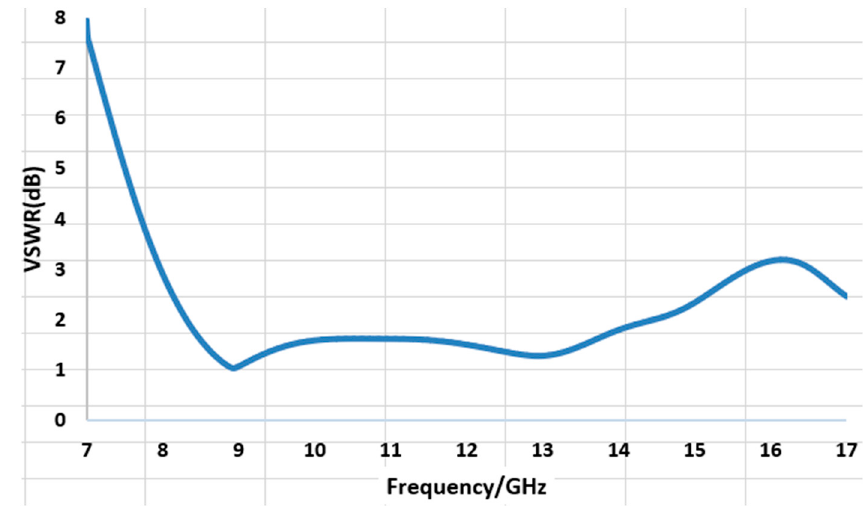
Figure 4. Simulated VSWR of the proposed MPA.